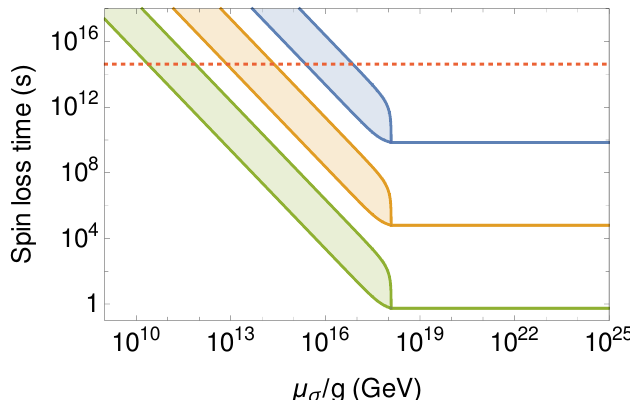
Figure 3 . The relation between the spin loss time by the hidden photon cloud and (cid:22) (cid:27) =g . The blue, orange and green bands are for (cid:22) A = 10 (cid:0) 20 ; 10 (cid:0) 15 and 10 (cid:0) 10 eV, respectively. The upper (lower) lines of the band correspond to C = 10 (cid:0) 6 (10 (cid:0) 3 ). The red dotted line shows the accretion time